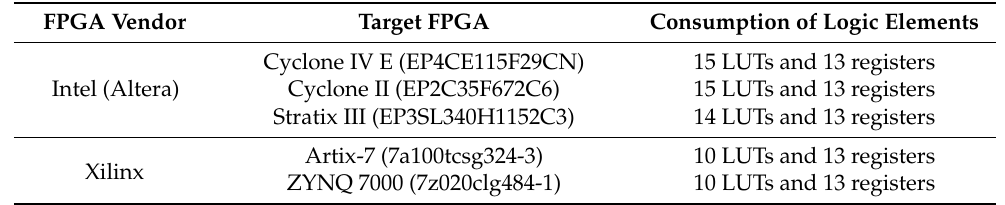
Table 8. Hardware resources of the proposed